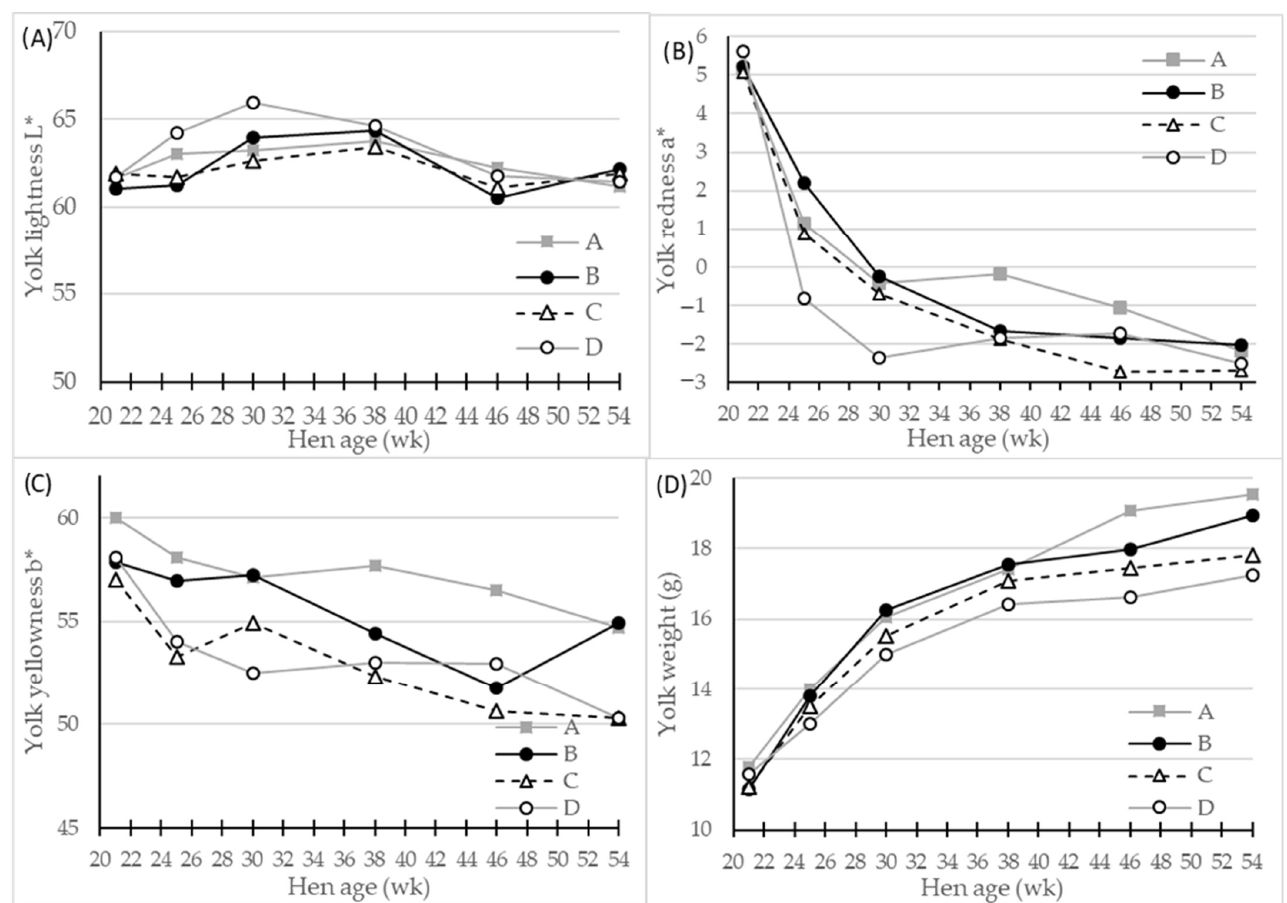
Figure 3 . The correct legend and corrected Figure 3 appear below.